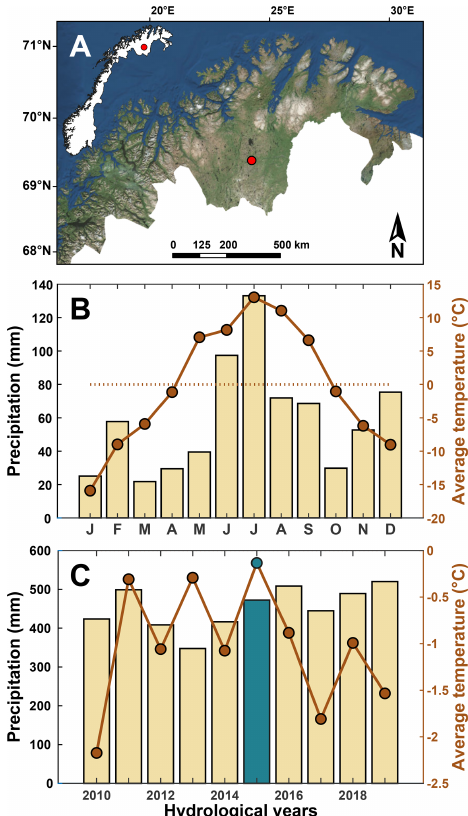
Figure 1. (a) Location of Šuoššjávri in northern Norway. (b) Monthly data of the model forcing to simulate the hydrologi- cal year 2015–2016. (c) Yearly data from the Cuovddatmohkki sta- tion located at 286ma.s.l., 7km east from Šuoššjávri (310ma.s.l.). The green bar and point indicate the hydrological year 2015–2016. Panel (a) is modified from Martin et al. (2019); a Landsat image is used for the